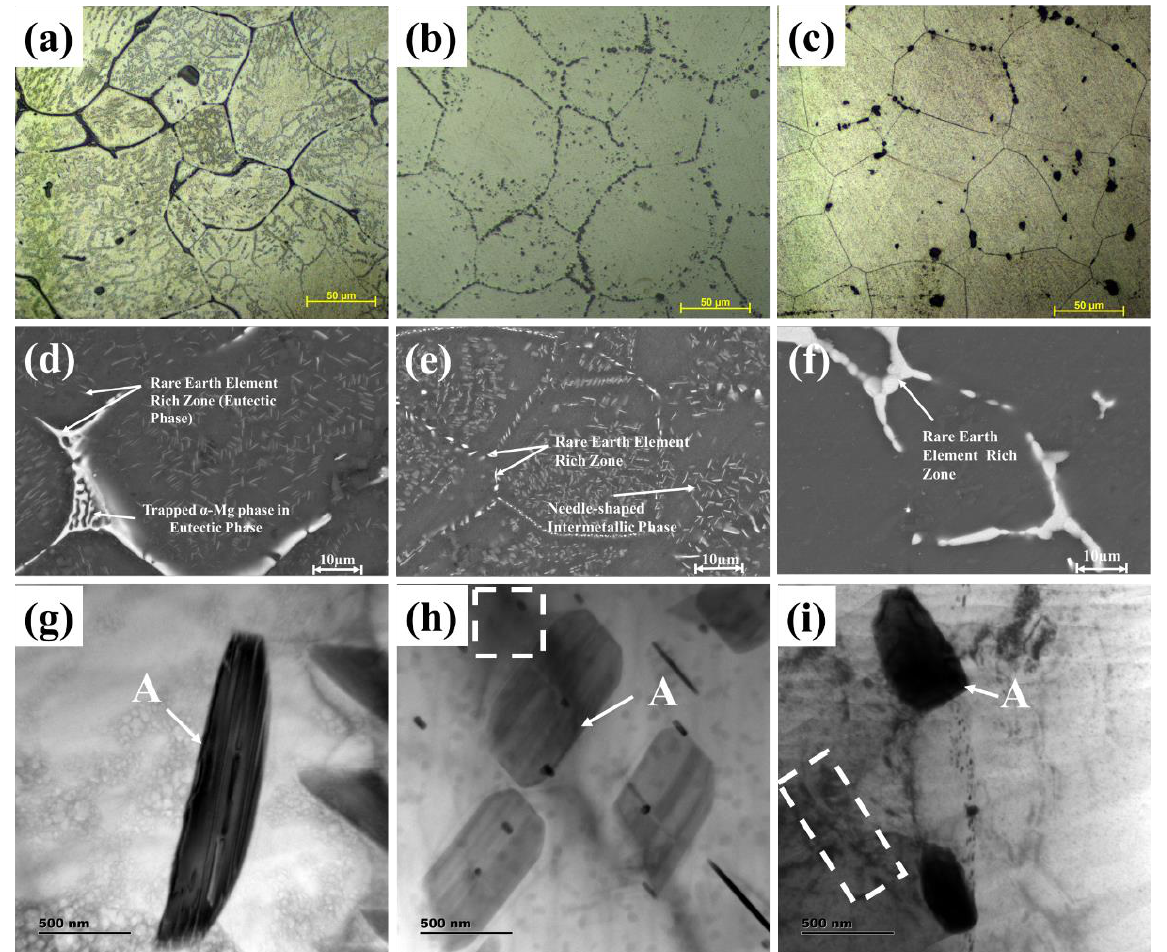
Figure 3. ( a – c ) Optical micrographs; ( d – f ) FE-SEM micrographs of EV31A; ( g – i ) Precipitates in studied alloy — TEM analysis. ( a , d , g ) As-cast; ( b , e , h ) after T4 heat-treatment; ( c,f , i ) after T6 heat- treatment. “A” point in Figure 3 ( g – i ) represents the precipitates, and the white rectangle in Figure 3 ( h ) and ( i ) represents dislocations.